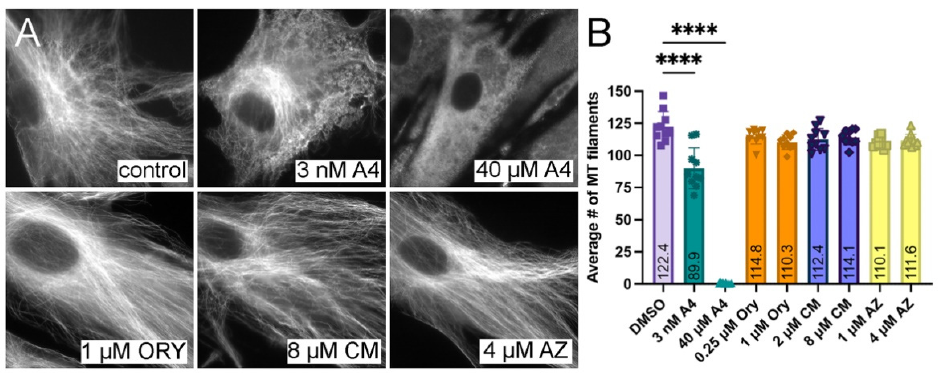
Figure 3. Quantification of vertebrate microtubules after drug treatment. ( A ) Tubulin immunofluorescence staining of HFF cell monolayers after 1 h of exposure to media containing the DMSO vehicle or drugs dissolved in vehicle permits visualization of tubulin subunits (diffuse staining) and assembled microtubules (filamentous structures). Scale bar = 10 µm. ( B ) Wide-field immunofluorescence images were analyzed with the open-source software SFEX to enumerate assembled microtubules by quantitative analysis of segmented filaments. The average number of microtubules in cytoplasmic regions of interest is only significantly different between the DMSO control and combretastatin A4 treatment, which partially or completely disrupts vertebrate microtubules. Statistical analyses were run using an ordinary two-way ANOVA. The results represent the average of 30 measurements (3 biological replicates with 10 fields of view for each treatment) ± standard deviation. Drug abbreviations: A4: combretastatin A4; Ory: Oryzalin; CM: clemastine; AZ: astemizole. ****: p values less than 0.0001.